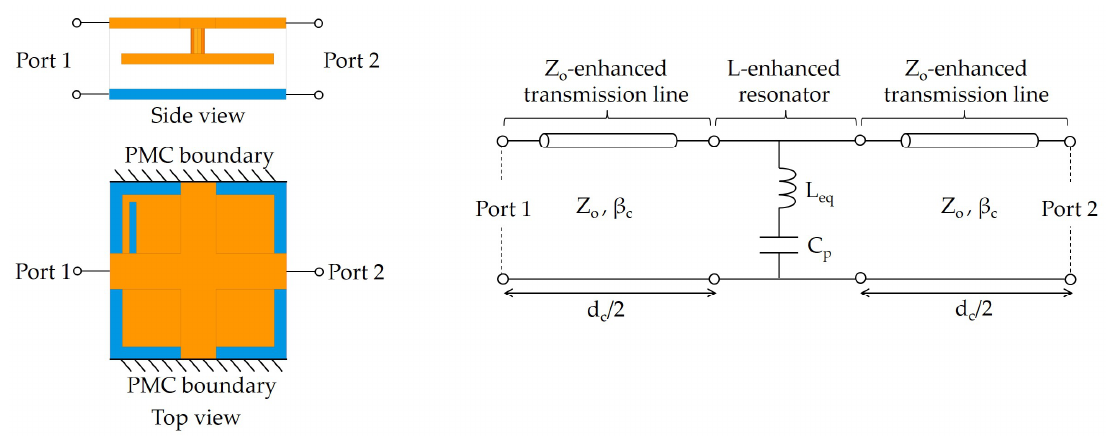
Figure 2. Equivalent circuit model of the DP–EBG unit cell based on transmission line theory for the extraction of the dispersion equation.